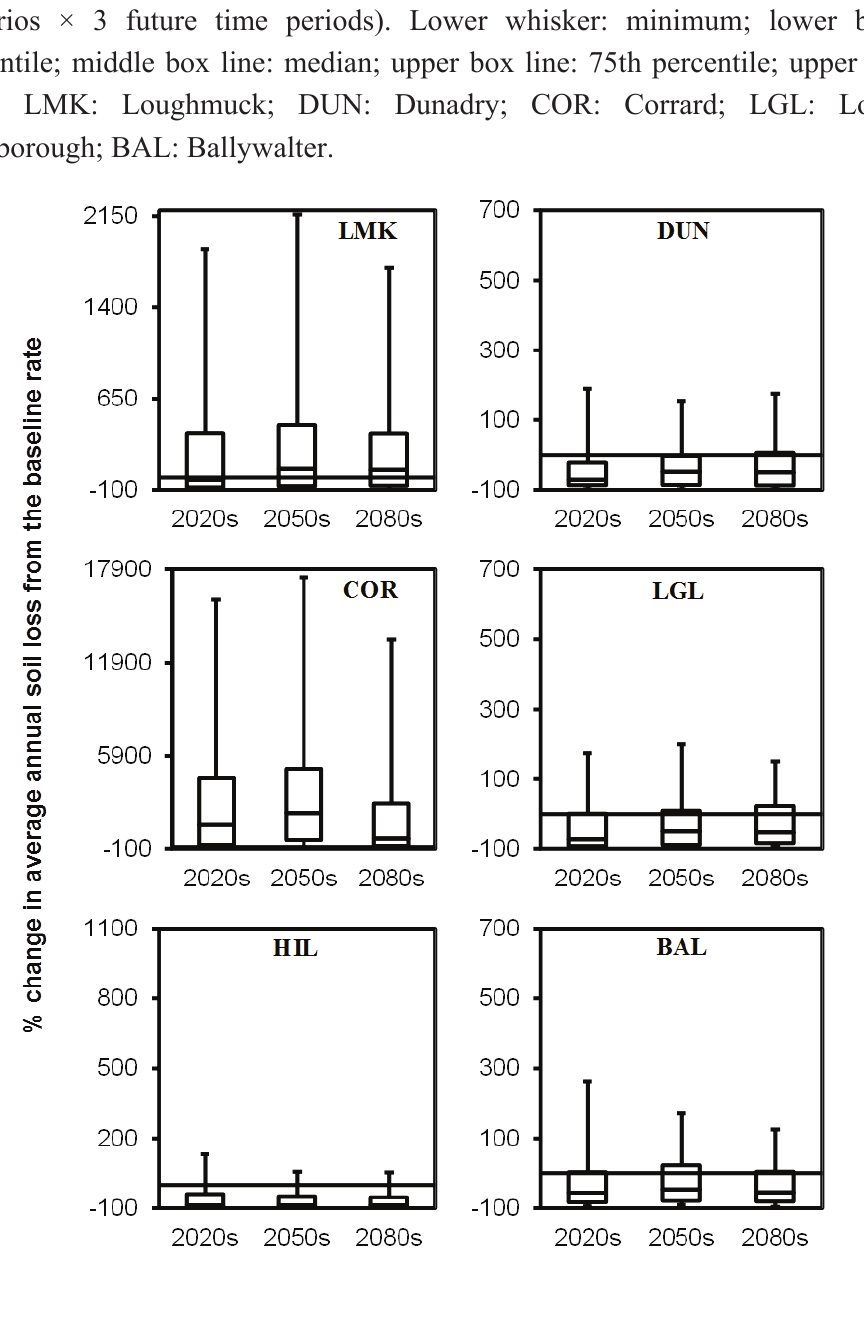
Figure 2. Percentage change in soil loss for three future time periods relative to the modelled present-day baseline erosion rate for six hillslopes in Northern Ireland under future climate and land use change scenarios [15]. The full distribution at each hillslope accounts for 216 future scenarios (3 GCMs × 2 emissions scenarios × 3 ensembles × 4 land use scenarios × 3 future time periods). Lower whisker: minimum; lower box